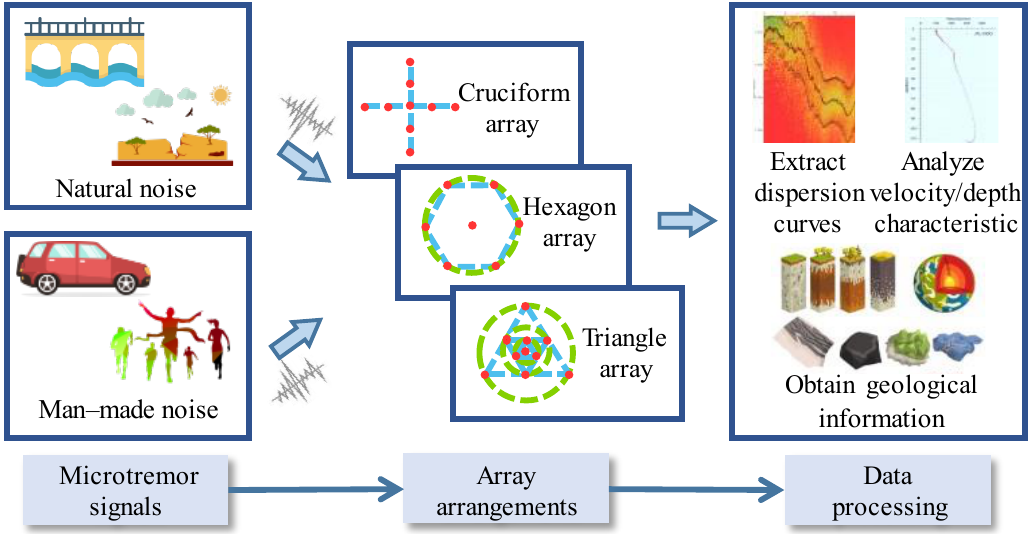
Figure 1. The typical applications and procedures of microtremor exploration.